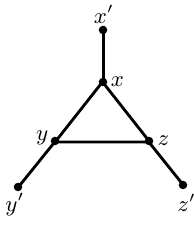
Fig. 3: The graph I